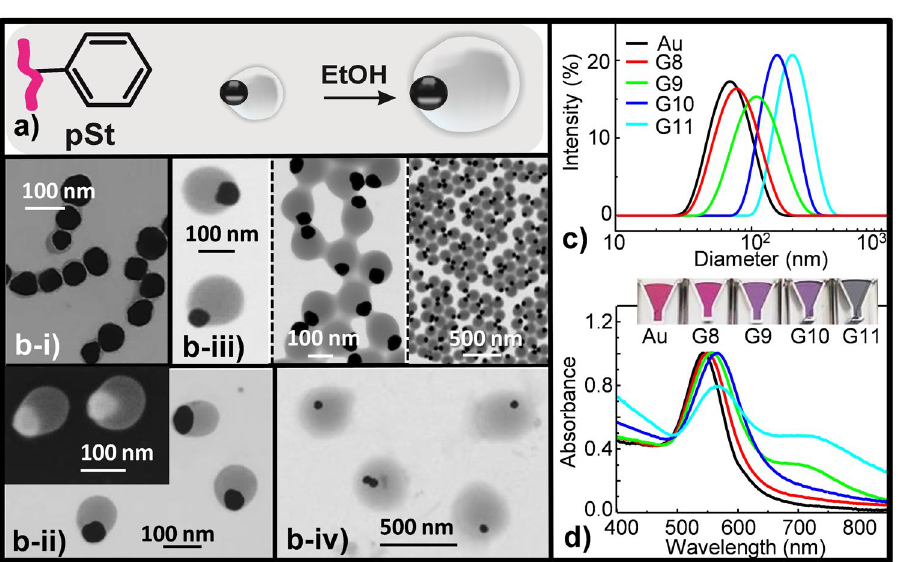
Figure 4. ( a ) Schematic depiction of eccentric or Janus core-shell nanohybrids consisting of pSt shell coverage anisotropically grown on AuNP; ( b ) S-TEM images of distinct morphologies of Au@pSt nanohybrids obtained with ethanol concentration increasing: ( b -i) G8, ( b -ii) G9, ( b -iii) G10 at different magnification, and ( b -iv) G11. Right-hand of ( b -ii) illustrates SEM image of G9; ( c ) Size diameter by intensity distribution and ( d ) Extinction spectra of AuNP and the corresponding G8-G11 nanohybrids shown in b (i-iv). Inset: color variation of the Au@pSt nanohybrid solutions with shell-morphology evolution from concentric core-shell to eccentric and